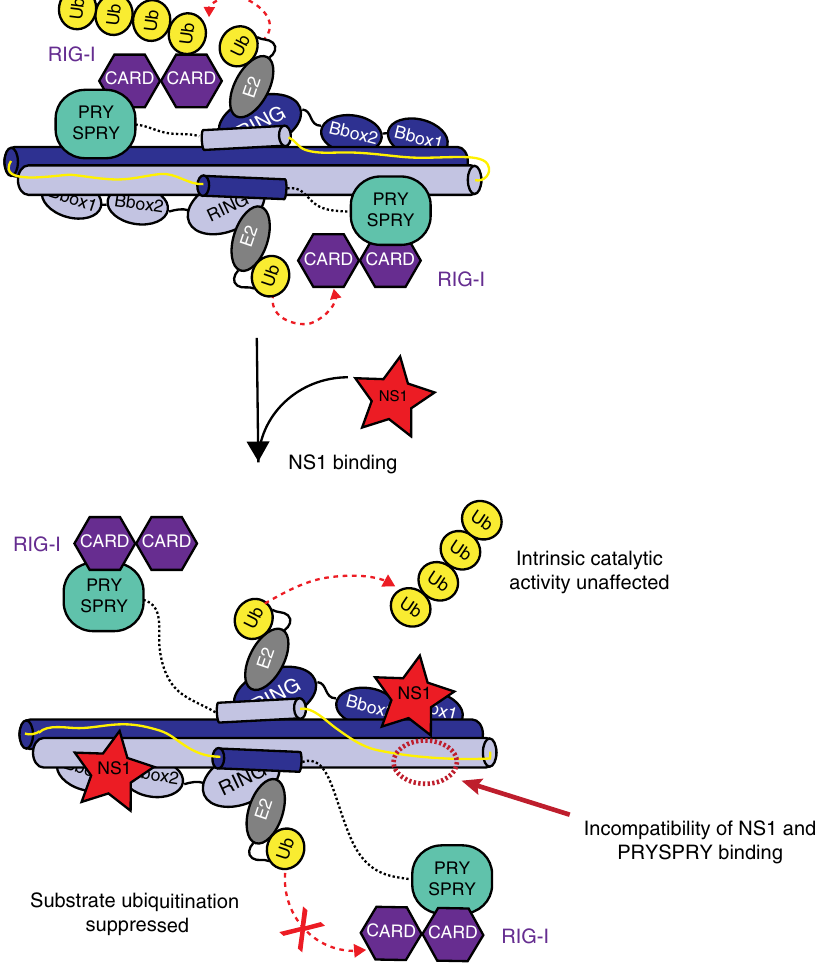
Fig. 6 Model for suppression of substrate ubiquitination by NS1. Model of TRIM25 activity highlighting how the RING domains either side of the anti- parallel CC bind back to dimerise in an intramolecular fashion and come into close proximity of the substrate-binding PRYSPRY domain. The monomers of dimeric TRIM25 are shown in light and dark blue, with ubiquitin-loaded E2 (E2-Ub) in grey and yellow bound to each RING domain while the tandem CARDs of RIG-I (in purple) are bound to the PRYSPRY domain (in green cyan) of TRIM25. The linker connecting the CC and PRYSPRY domain is highlighted in yellow. Binding of NS1 (in red) to the CC of TRIM25 interferes with the linker position and hence correct arrangement of the PRYSPRY domain with respect to the RING domains to suppress substrate